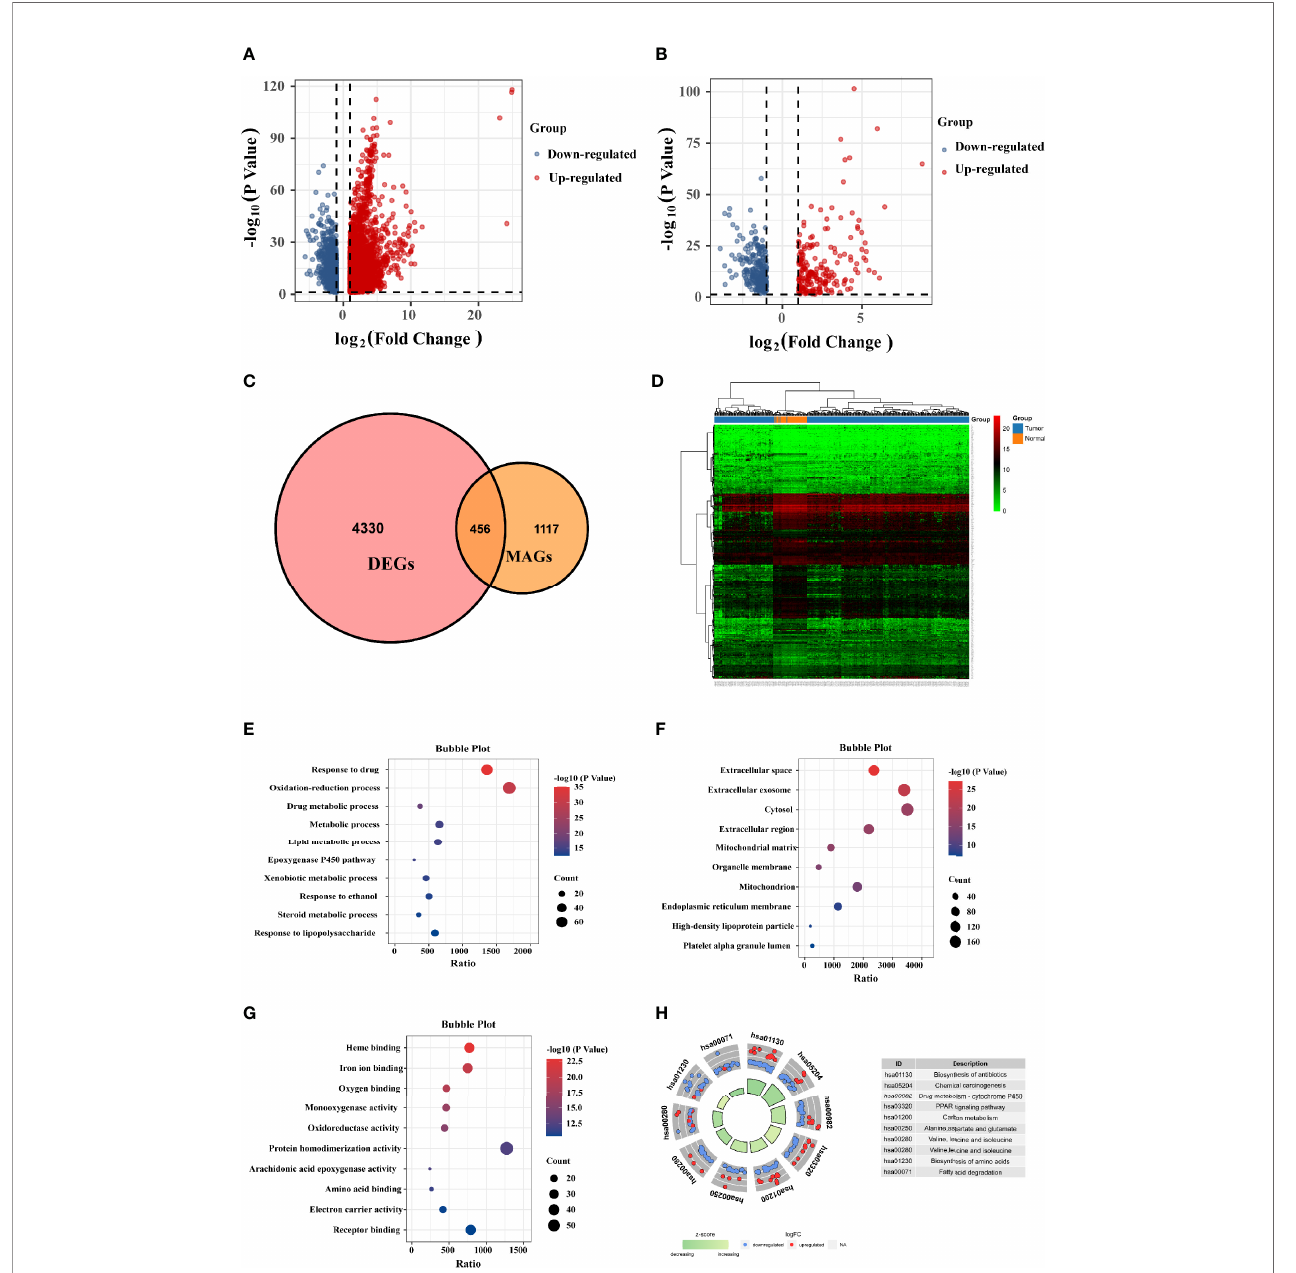
FIGURE 1 | Identi fi cation of differentially expressed (DE)-MRGs and function enrichment analysis. (A) Volcano plot of DEGs in TCGA HCC samples. Genes with FDR <0.05 and FC >1.0 or <-1.0 are considered DEGs. Blue: downregulated genes; Red: upregulated genes. (B) Volcano plot shows 456 DE-MRGs in TCGA HCC samples. (C) Venn diagram indicating 456 DE-MRGs in the HCC cohorts of TCGA database. (D) Heat map shows the expression of 456 DE-MRGs in tumor and peri-tumor tissues. (E – G) Pathway enrichment by GO functional analysis. (H) The KEGG circle shows the scatter map of the logFC of the speci fi ed gene. Higher Z- score values indicate higher expression of the enrichment